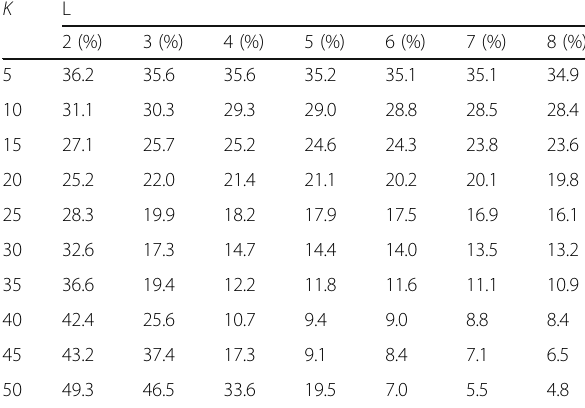
Table 1 Error rate of the different